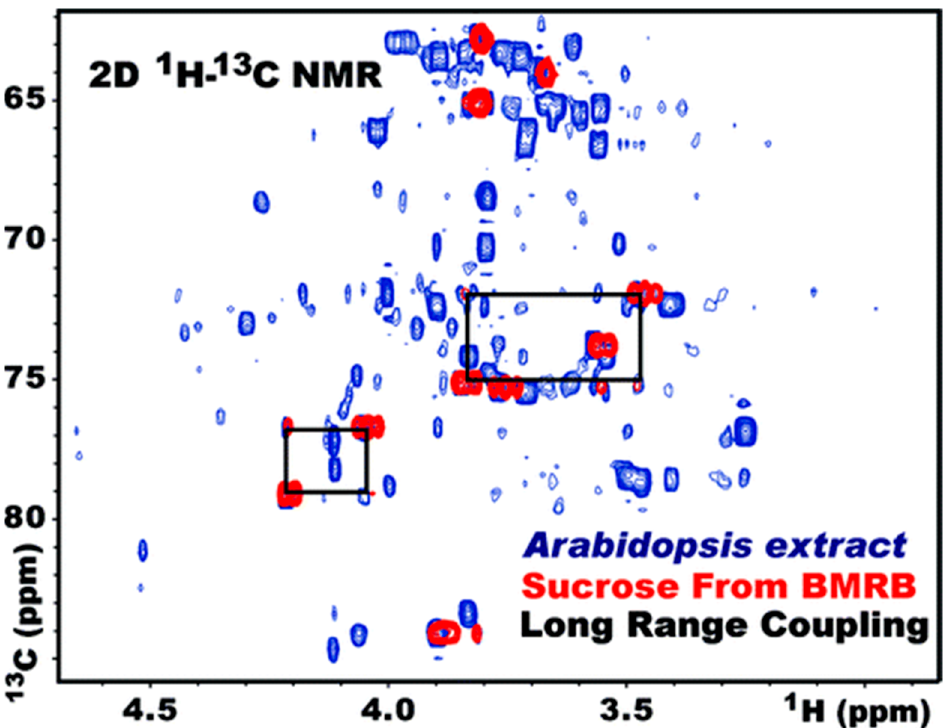
Figure 6. 2D 1 H − 13 C HSQC NMR spectrum of sucrose from the Biological Magnetic Resonance Data Bank (red) overlaid onto an aqueous whole-plant extract from Arabidopsis thaliana (blue) [162].